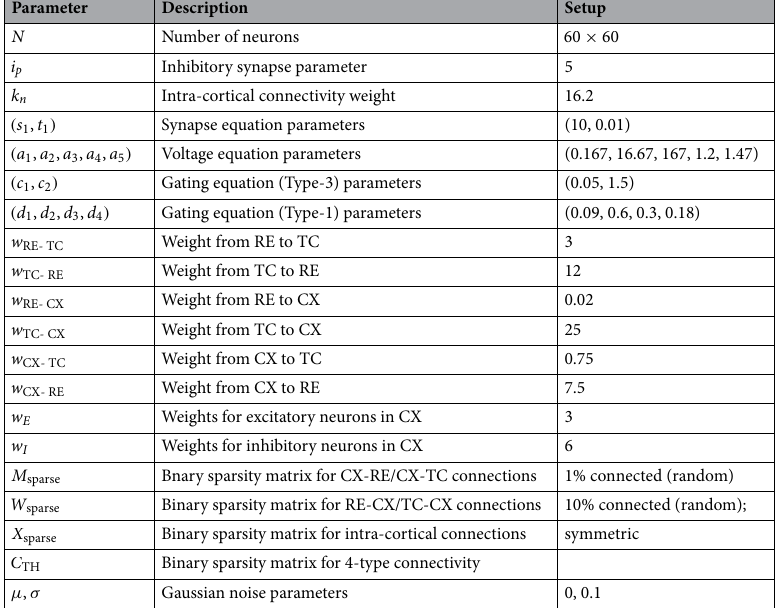
Table 1. A tabular summary of computer simulation setup and parameters for the three-layer thalamocortical system.